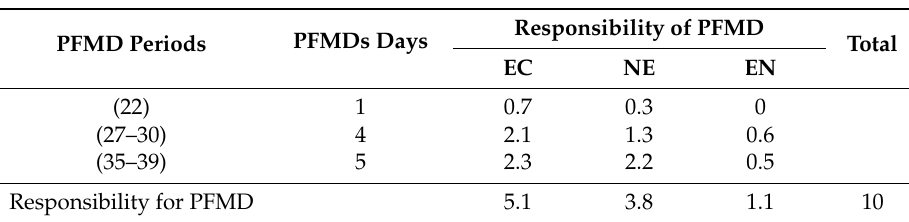
Table 10. The result of the PFMD method.